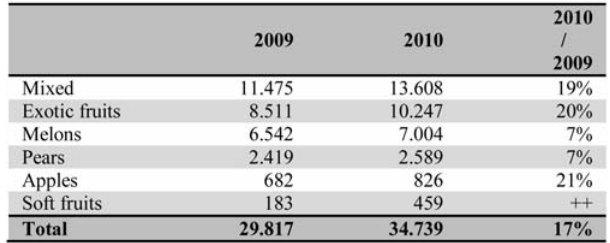
Table 11. Supermarket Sales for pre-treated fresh fruit